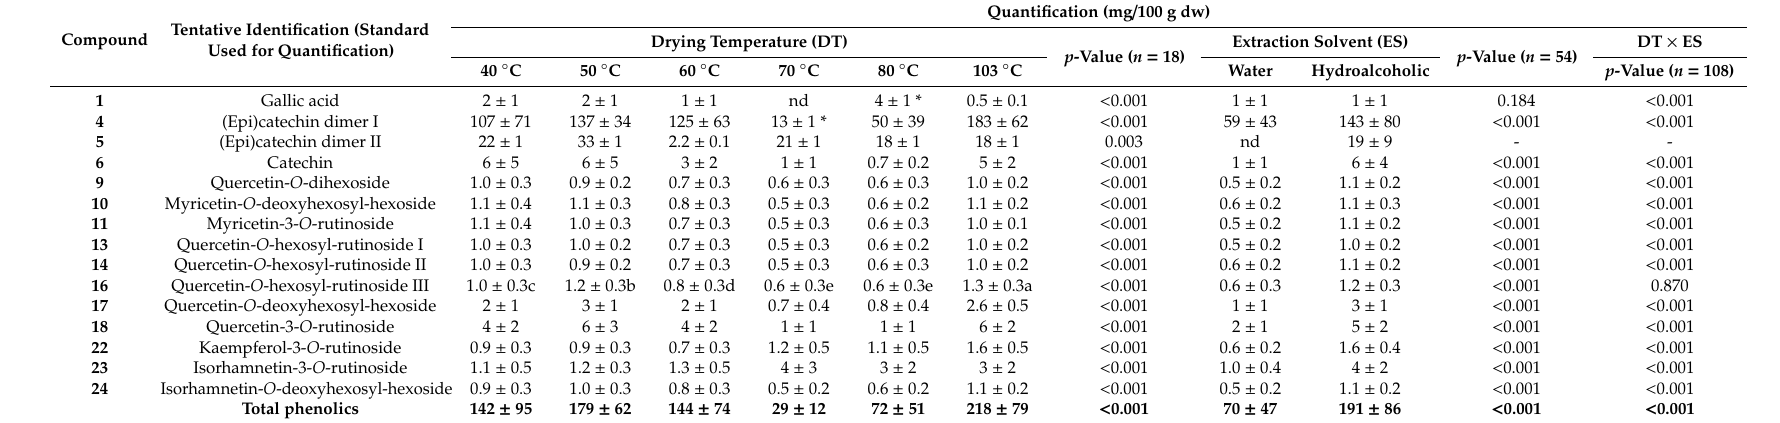
Table 4. Phenolic compound quantification in C. urucurana Baill. stems submitted to di ff erent drying and extraction conditions. Compound Tentative Identification (Standard Used for